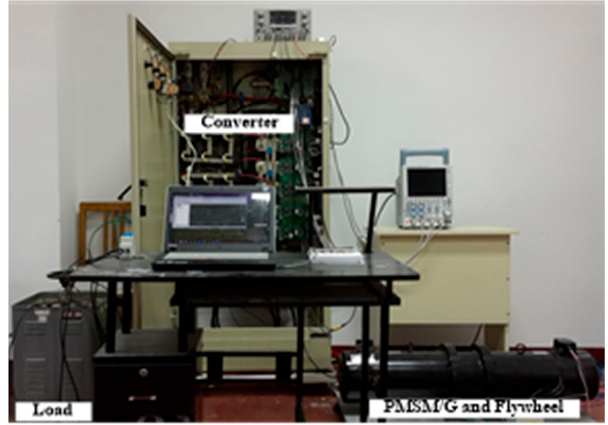
Figure 4. The high-speed PMSM prototype used in the experiment. Table 1. Parameters of the PMSM/G and converter.